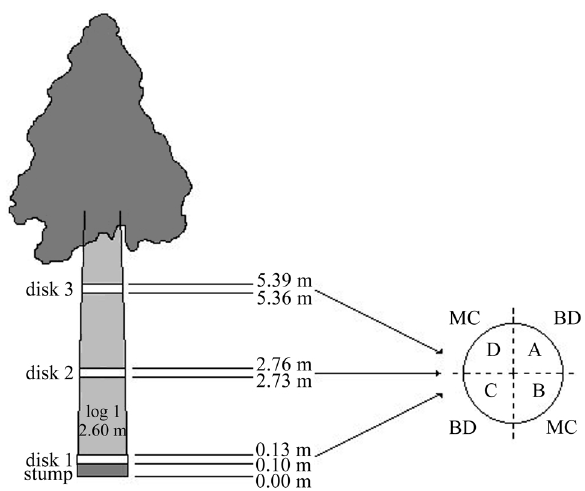
Figure1 -Samplingpositionsofloganddisksusedforwoodcharacteriza- tion.A,B,CandD-woodwedges,BD-basicdensity,MC-moisturecon-